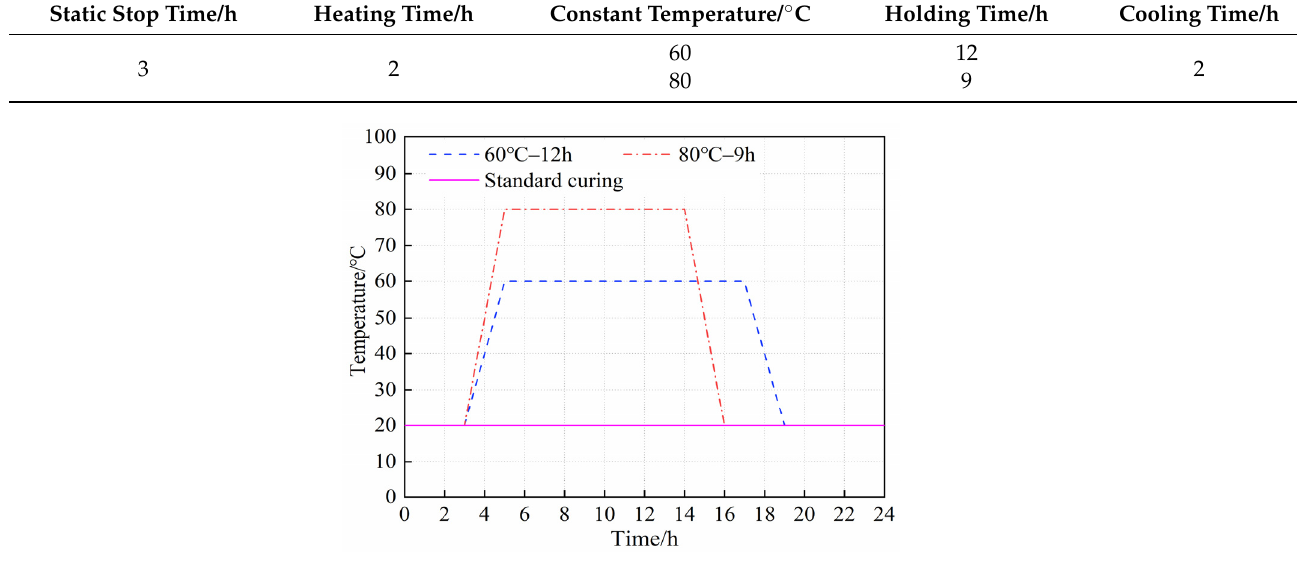
Figure 2. The curves of curing temperature versus